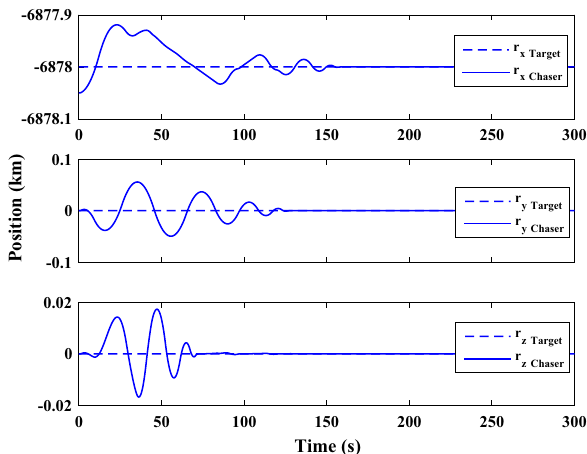
Figure 22. Scenario I: position tracking (in desired frame).